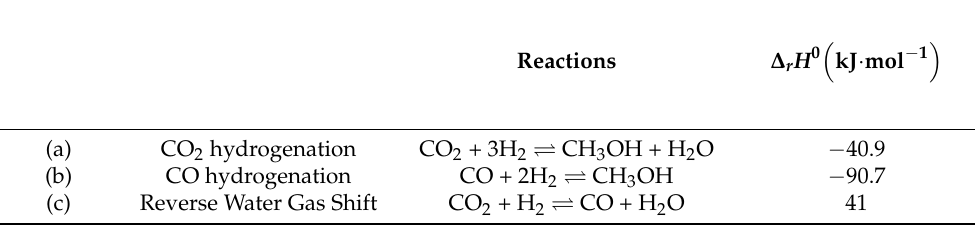
Table 2. Chemical reactions involved in the methanol synthesis (enthalpy of reaction at 298 K).